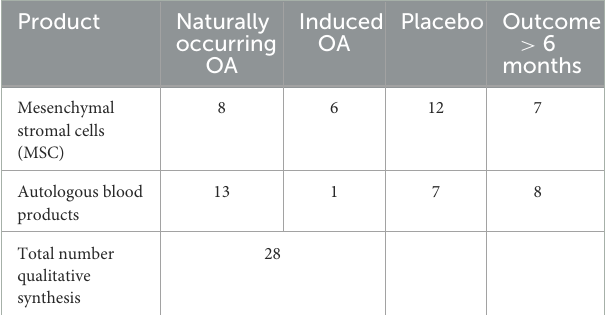
TABLE 3 Numbers of studies from qualitative synthesis including naturally occurring OA compared to induced OA, trials with a placebo group, and studies with a follow-up time over 6